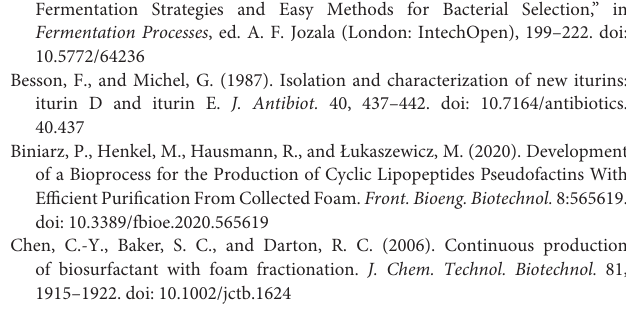
Supplementary Figure 1 | Geometrical factors expressed in cm of the stirred tank reactor. D i = 7,65; H L /D i = 1,83; D t /D i = 2,22; H 0 /D i = 1,00; W i /D i = 0,20; L i /D i = 0,25. Supplementary Figure 2 | Annotated chromatograms of (A) iturin A standard, (B) mycosubtilin and (C) surfactin from shake flasks experiments. A volume of 20 µ L was injected and analyzed using a C18 column (5 µ m, 250 × 3.0 mm, 218 TP, VYDAC, Grace) on Acquity UPLC system (Waters, Milford, MA, United States). Mycosubtilins (and iturin A standard) were eluted with a ACN/H 2 O/TFA solvent, 40:60:0.1, V/V/V, and surfactins with a ACN/H 2 O/TFA 80:20:0.1 solvent,